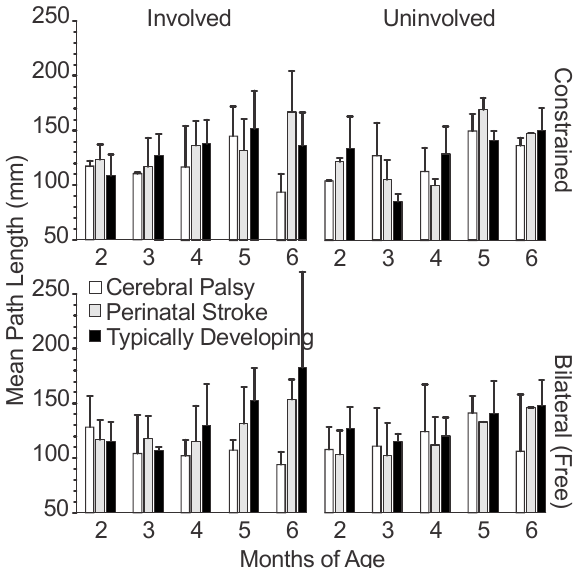
Figure 3. Mean hand path length by age, side, and condition. For typically developing infants, the left arm is plotted alongside the involved limb and the right arm is plotted alongside the uninvolved limb. Error bars show 1 standard deviation.